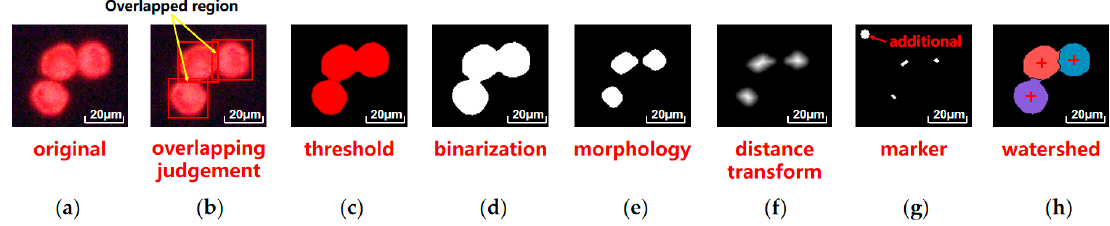
Figure 3. Process of watershed algorithm based instance segmentation: ( a ) Original cell image; ( b ) Overlapping judgement by detecting the overlapped region of the bounding boxes; ( c ) Red color channel is remained by setting threshold; ( d ) Binarization with the Otsu adaptive threshold method; ( e ) Morphology erosion and dilation operation to separate cells; ( f ) Distance transform to refine regions; ( g ) Markers generation by threshold and find contours; ( h ) Targets separation by watershed algorithm.